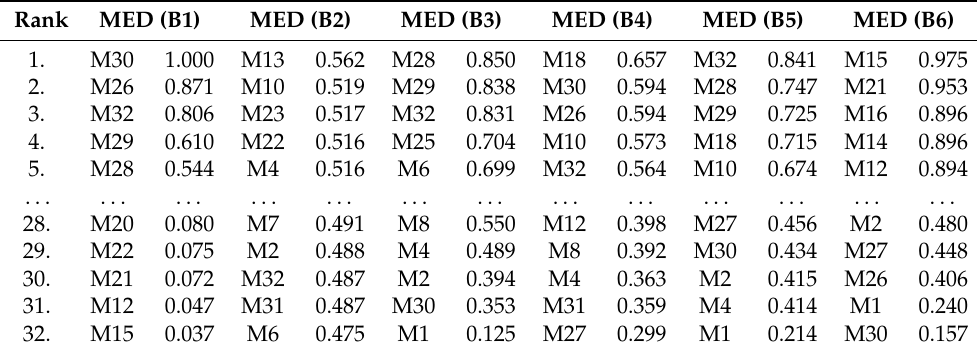
and B6 throughout the entire monitored